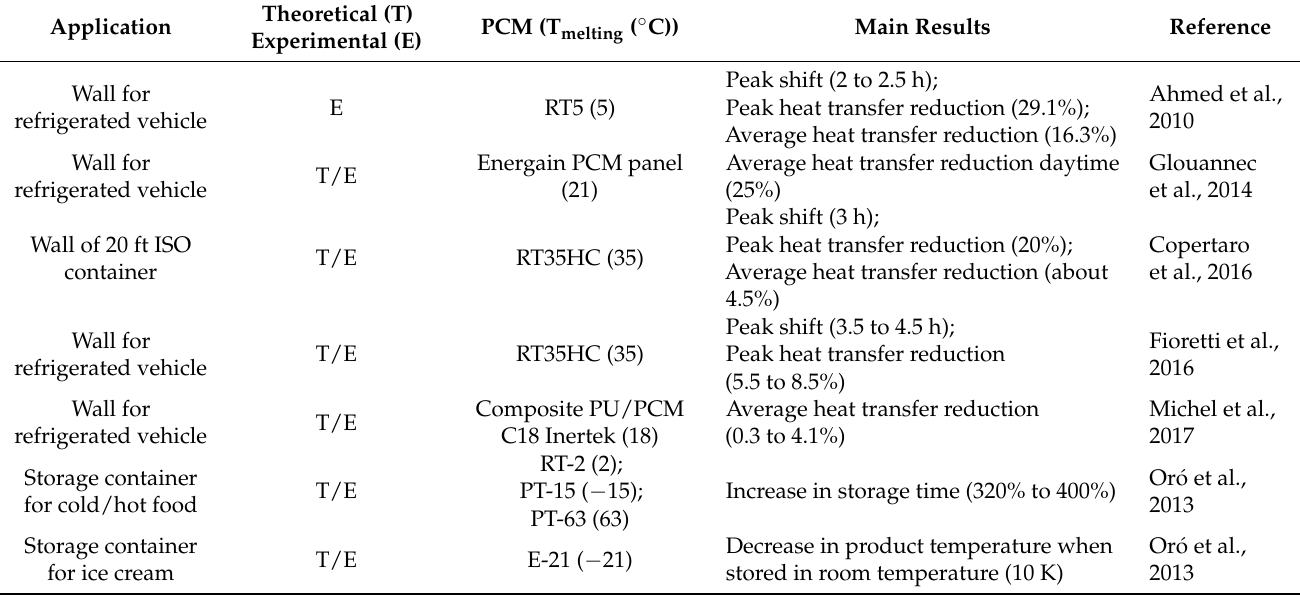
Table 15. Main results from use of PCM in food transport and packaging. Reprinted from ref.